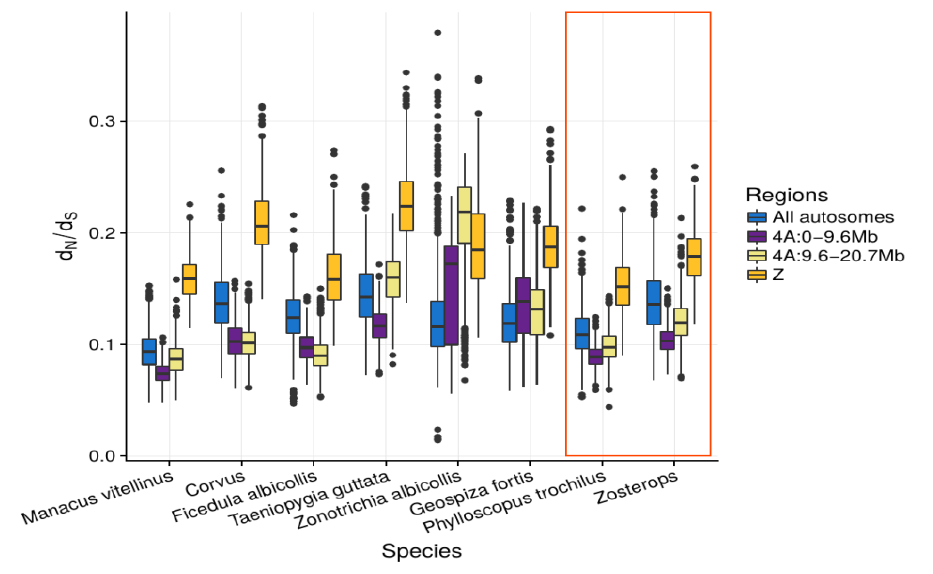
Figure 6. Variation in d N /d S ratios among chromosomal regions for the 11 investigated species. Estimates are performed at the genus level, i.e. on branches before the split of the two Corvus (C. cornix and C. brachyrhynchos) and the three Zosterops species (Z. lateralis, Z. pallidus and Z. borbonicus). The red box shows species with the translocated neoZ-4A region For these species, the 4A:0-9.6 Mb region corresponds to the neoZ-4A and the Z corresponds to the